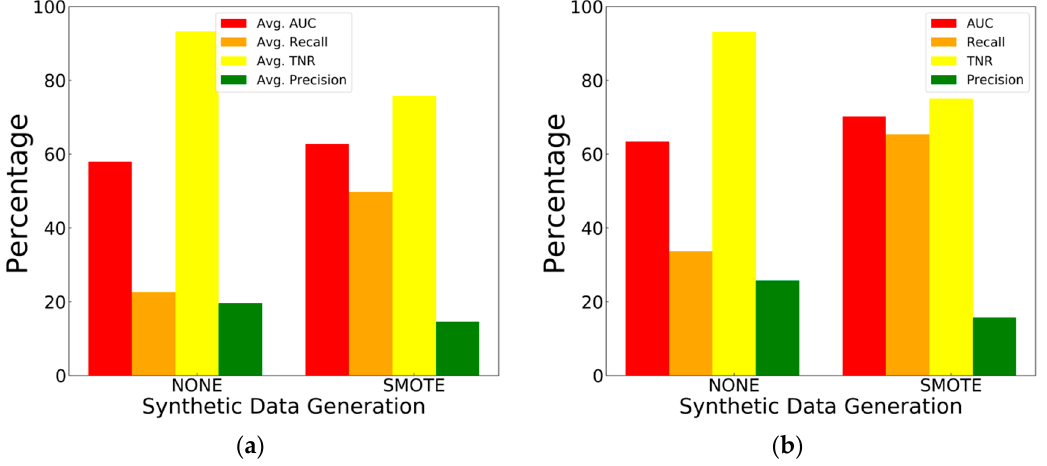
Figure 12. Classification results on balanced and imbalanced data: ( a ) Average of all approaches; ( b ) The best approaches (highest AUC).